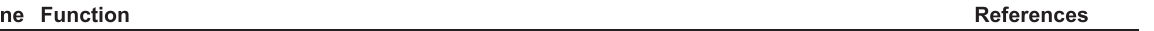
Table 1. Some cytokines of interest in autism [87] Cytokine